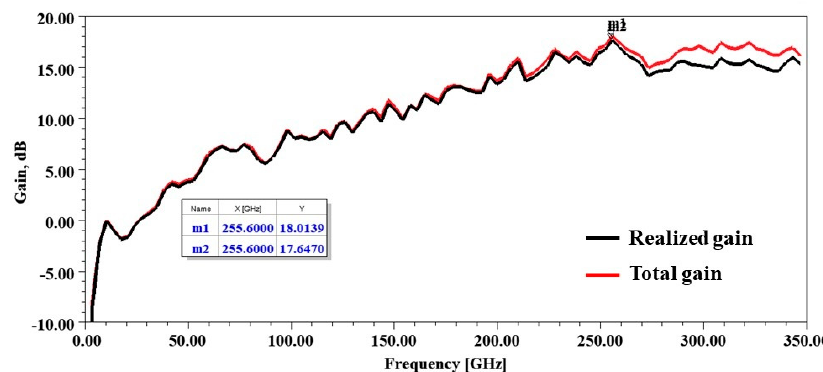
Figure 9. Gain − characteristics of the suggested antenna. Figure 9. Gain–characteristics of the suggested antenna.